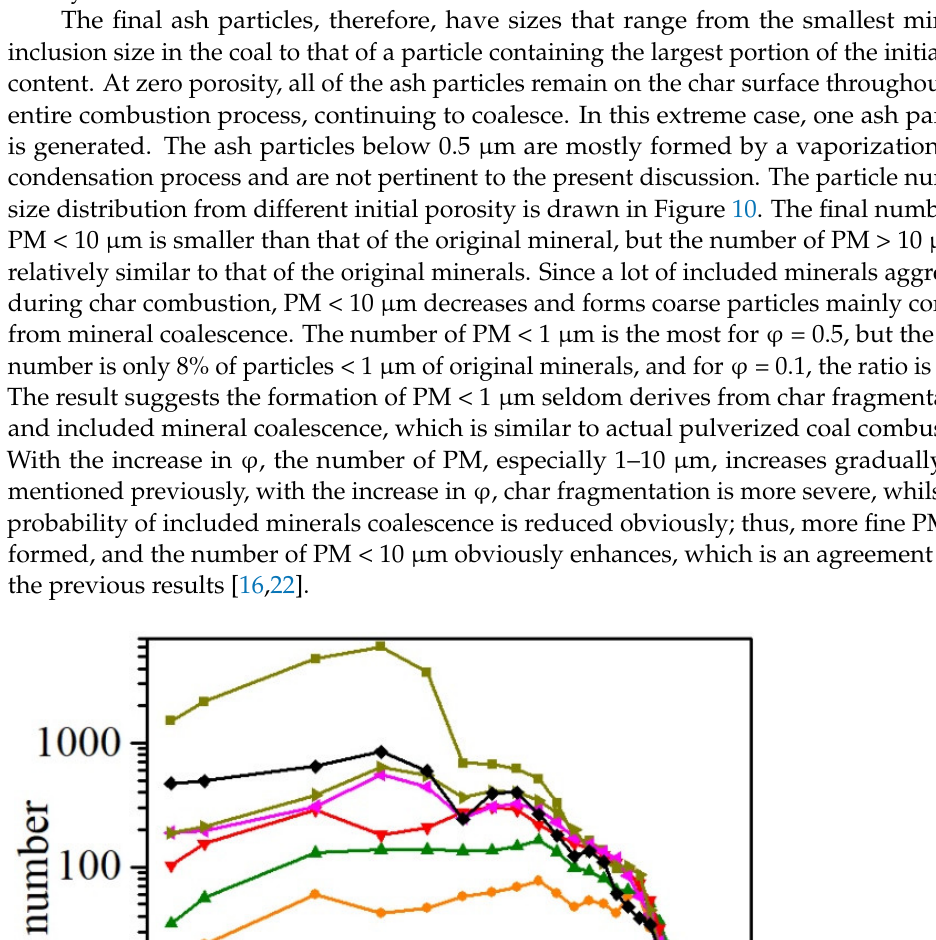
Figure 11. Particle volumetric (concentration) size distribution. 4. Conclusions A site percolation model of char fragmentation and mineral partitioning during dense and porous char combustion in a kinetically controlled regime is reported in this paper. Following conclusions can be drawn: increasing porosity enhances the surface re- action area and the number of fragments. The number of fragments and surface reaction area is higher for φ ≥ 0.4 compared to that for φ < 0.4. The char fragmentation concentrates on the early stage of char conversion gradually with increasing φ; if φ ≥ 0.4, char fragmen- tation obviously focuses on the conversion stage of 0.4–0.6, and the tendency with peak value transferring to the earlier conversion stage can be found. With the increase in φ, the number of PM, especially 1.0–10 μm, increases gradually, as does concentration. In the condition of φ ≥ 0.4, the concentrations of PM < 10 μm are high, and their size of curves distribution are relatively similar. The coarse mode peaks are distributed mainly at 12–13